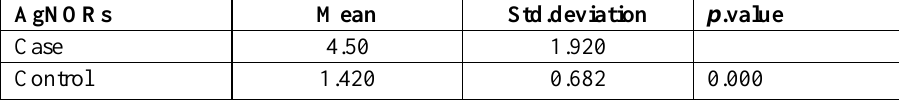
Table 1. Comparing the mean of AgNOR in users and control.